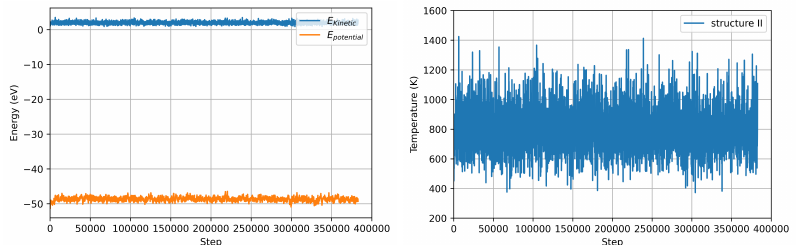
Figure 8. Energy (potential vs total) (left panel) and Temperature (right panel) fluctuations during LAMMPS MD simulation structure II.